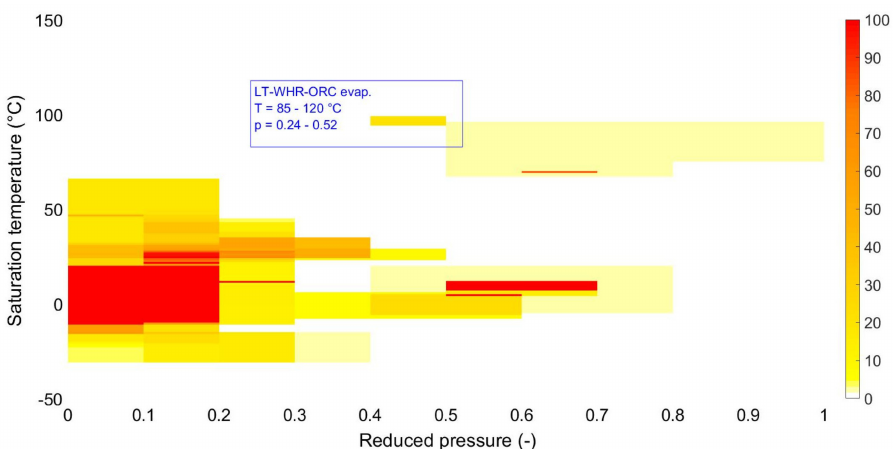
Figure 2. The experimental flow boiling data for horizontal plain tubes having an inner diameter higher than 6 mm from the literature between 1990–2021 plotted as the saturation temperature vs. reduced pressure, where the right bar is the point intensity